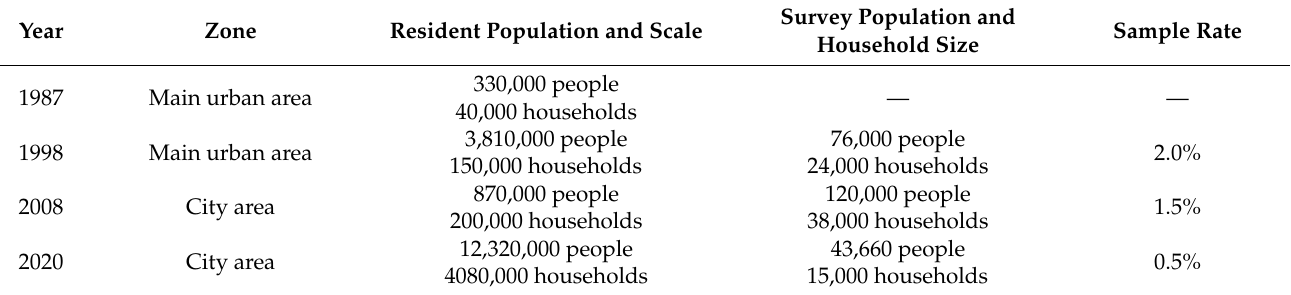
Table 1. Basic information of data collection of four trips of residents in Wuhan.